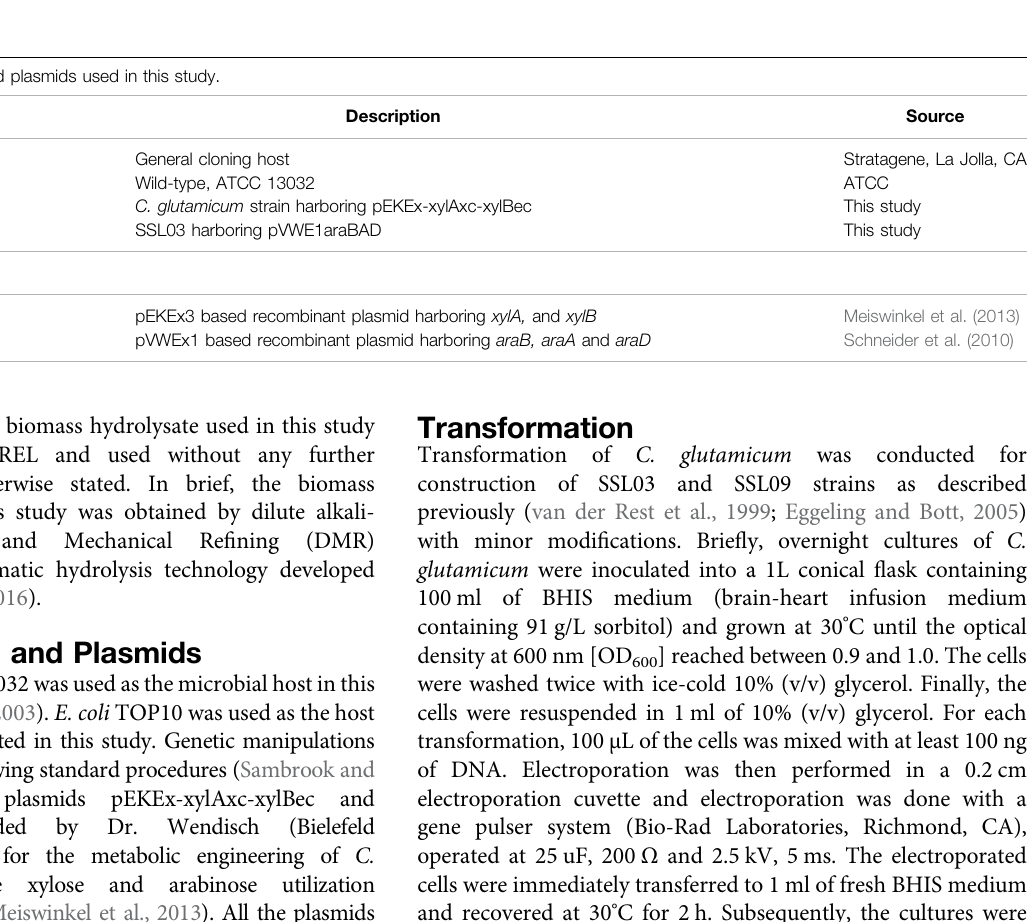
FIGURE 1 | Schematic representation of the overall process employed in this study. Corn stover was subjected to deacetylation and mechanical re fi ning (DMR) to obtain liquid biomass hydrolysate. The hydrolysate constituting glucose, xylose, arabinose, and aromatics was used as fermentation feedstock for C. glutamicum to produce mixed acids having various applications.